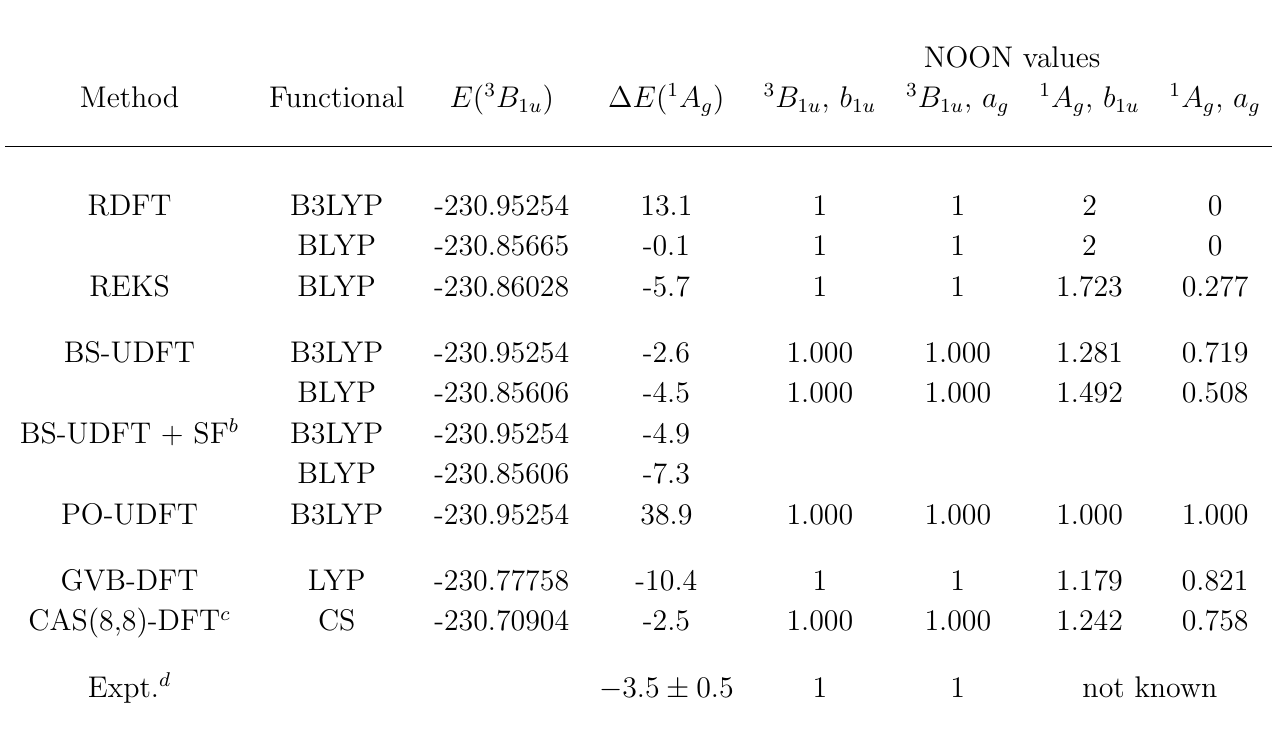
Table 3. Singlet and triplet energies for 1,4-didehydrobenzene ( 3 ). a